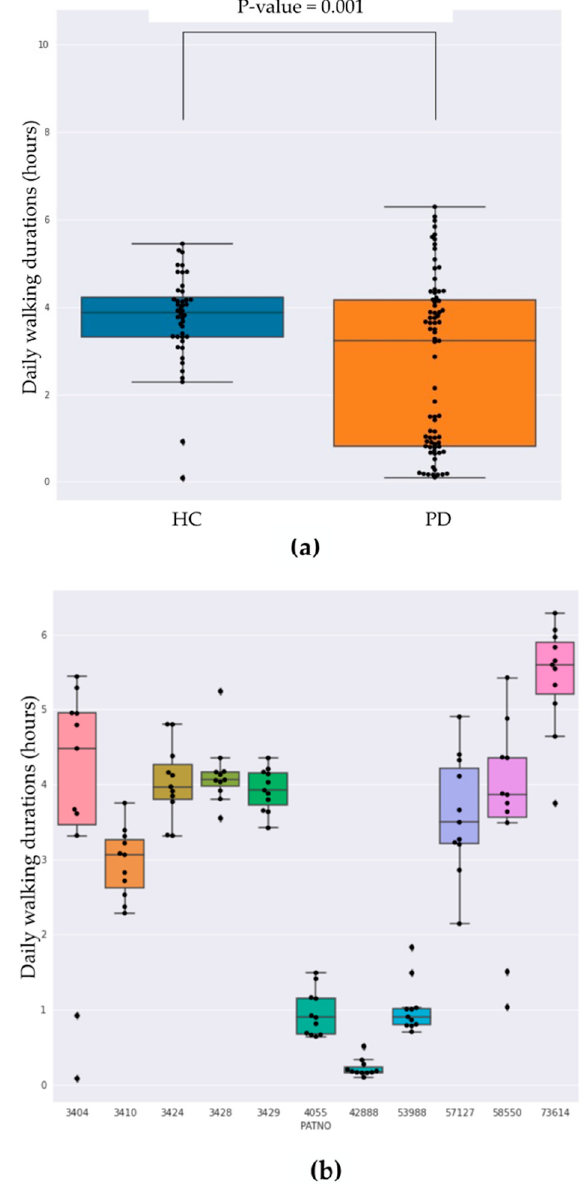
Figure 4. ( a ) Box plots showing the distributions of daily walk-like durations over the first 10 days of data collection summarized at the cohort level. ( b ) Box plots for each individual subject where the first five subjects are defined as healthy controls and the remaining are subjects with Parkinson’s disease. For both plots, whiskers indicate minimum and maximum values, excluding outliers.